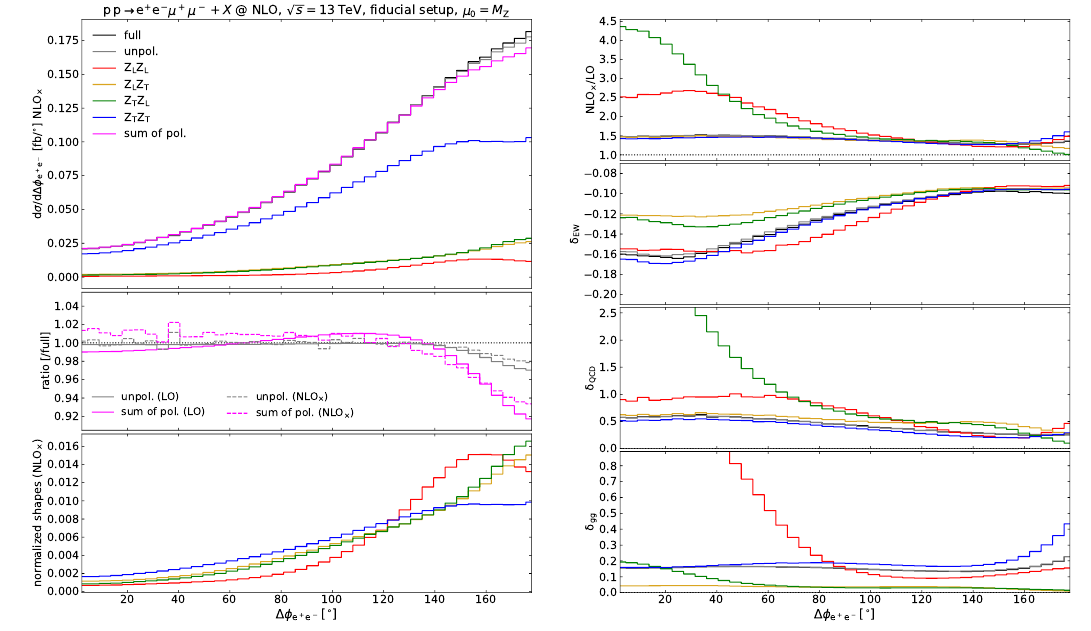
Figure 14 . Distributions in the azimuthal separation between the positron and the electron. Same structure as in figure